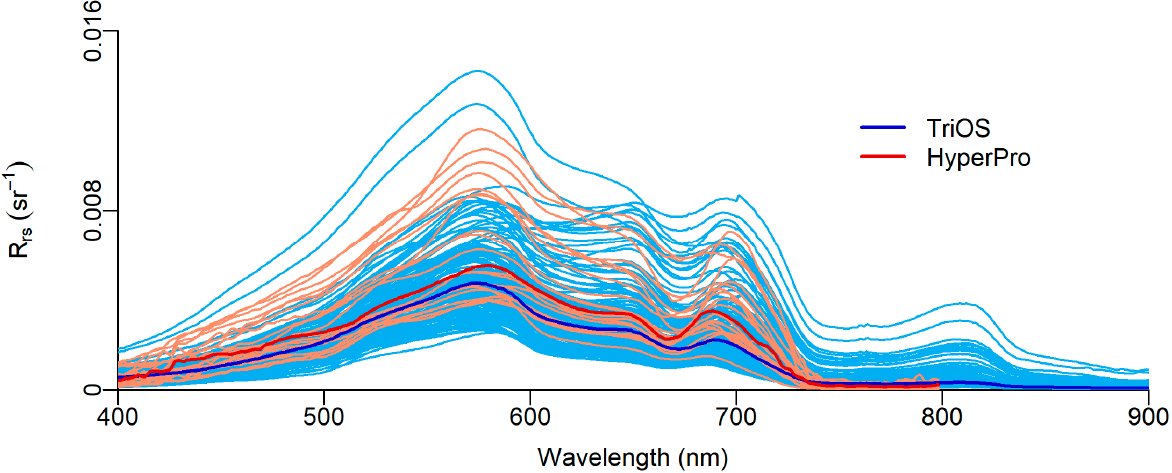
Figure 3. In situ R rs spectra collected with above-water hyperspectral TriOS radiometers (blue) and free-falling HyperPro radiometers (red) at 172 stations in the Upper and Middle Chesapeake Bay and Choptank River tributary between April 2016 and April 2020. The bold spectra represent the median R rs spectra for each in situ collection method.